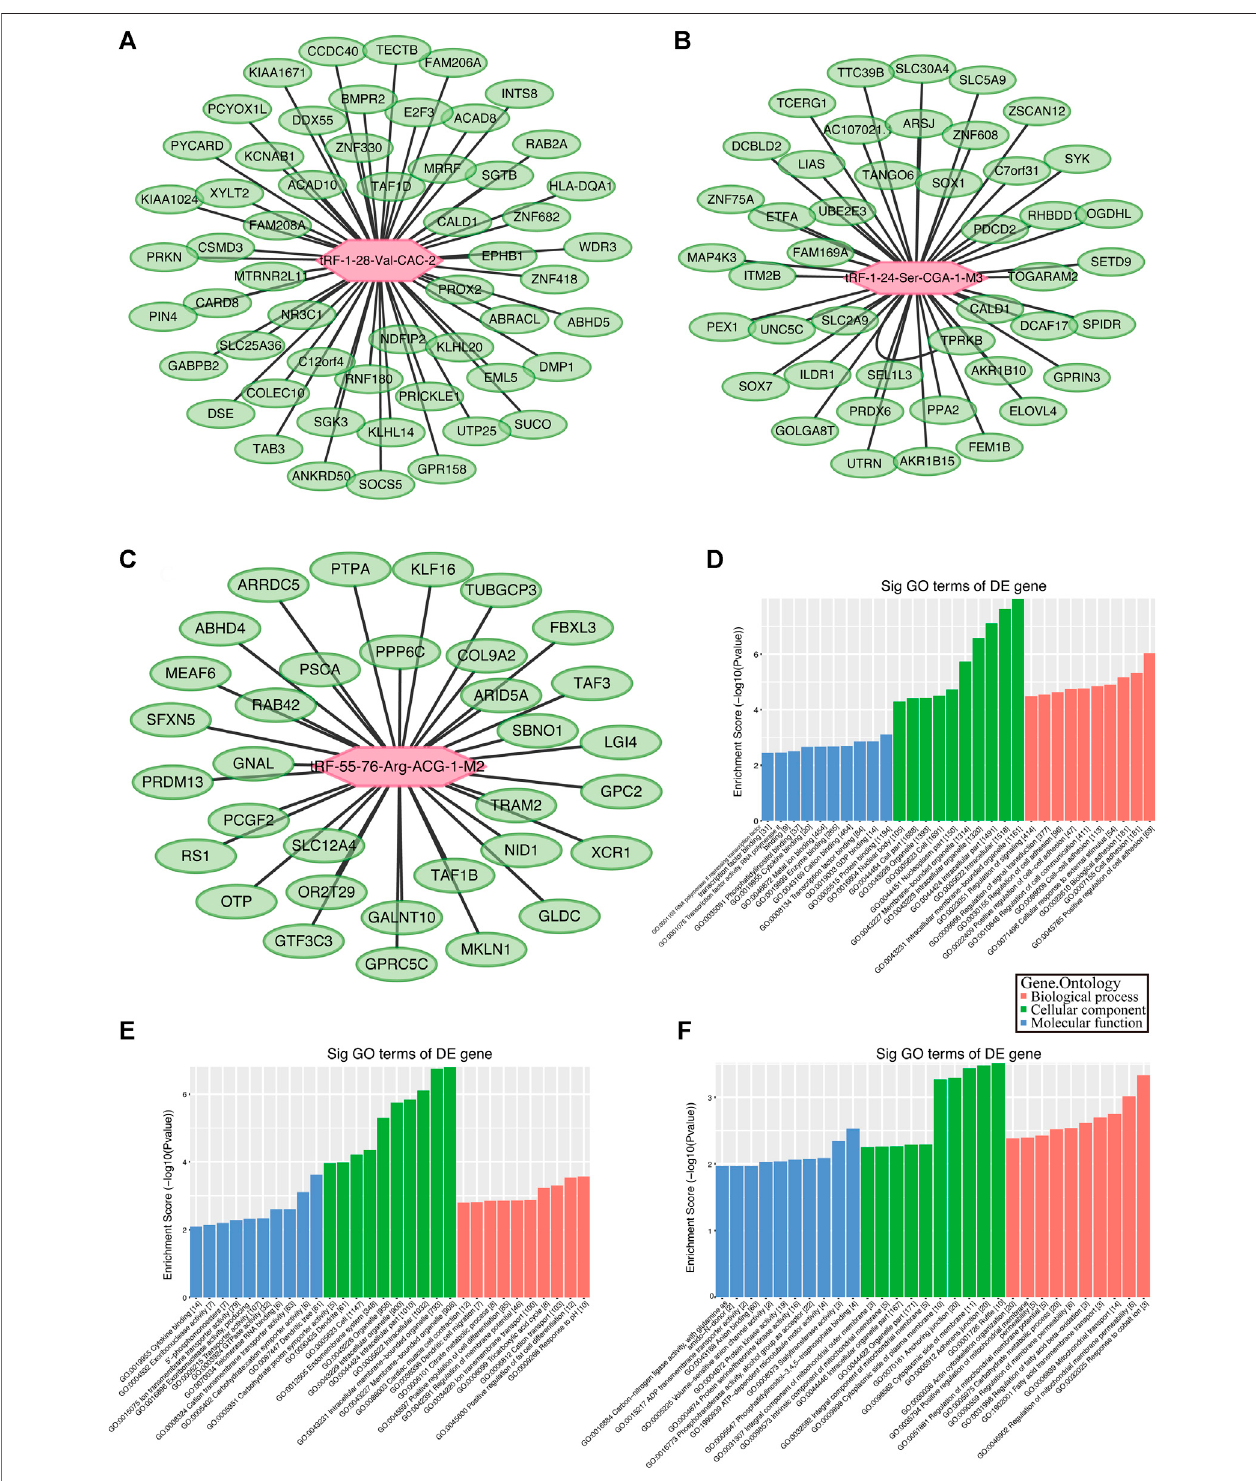
FIGURE 5 | Geneontology (GO)enrichmentanalysesfor tRF-1:28-Val-CAC-2, tRF-1:24-Ser-CGA-1-M3, andtRF-55:76-Arg-ACG-1-M2.PutativetargetmRNAgenesof (A) tRF-1:28-Val-CAC-2, (B) tRF-1:24-Ser-CGA-1-M3, and (C) tRF-55:76-Arg-ACG-1-M2 with context less than − 0.4. (D) GO analysis showed that the target genes of tRF-1:28-Val- CAC-2 mainly participated in regulation of cell communication and signal transduction. (E) Analysis revealed that tRF-1:24-Ser-CGA-1-M3 was a key participant in regulation of cell differentiation. (F) Analysis revealed that tRF-55:76-Arg-ACG-1-M2 is particularly responsible for fatty acid transmembrane transport and regulation of membrane permeability.